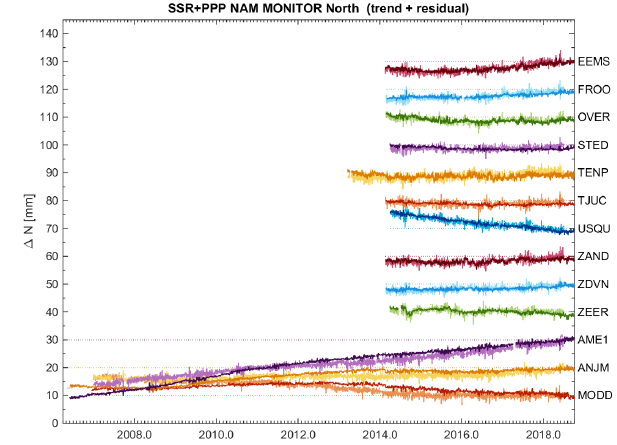
Figure 10. Overall concept of the Integrated Geodetic Processing